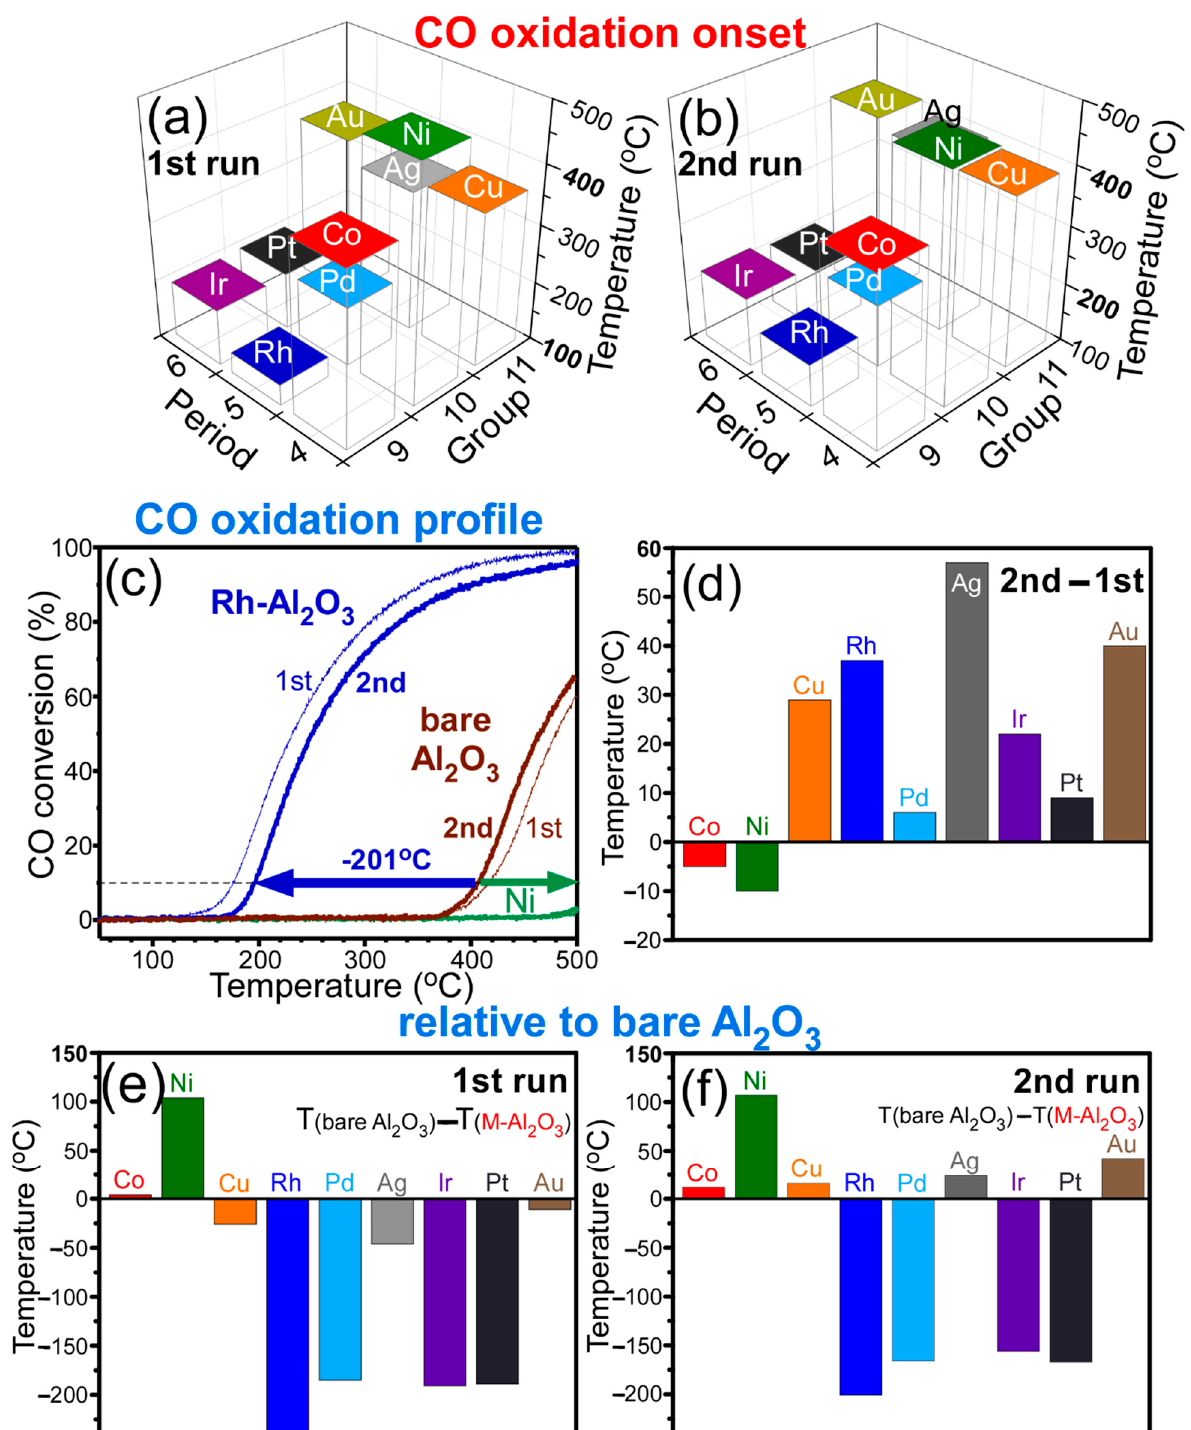
Figure 5. CO oxidation onsets for the first ( a ) and second ( b ) runs of M-loaded Al 2 O 3 nanosheets. Selected first and second run CO oxidation profiles with temperature ( c ) for bare, Rh- and Ni-Al 2 O 3 nanosheets. Differences in CO oxidation onsets for the first and the second runs ( d ) and relative CO oxidation onset temperatures relative to that of bare nanosheets ( e,f ).